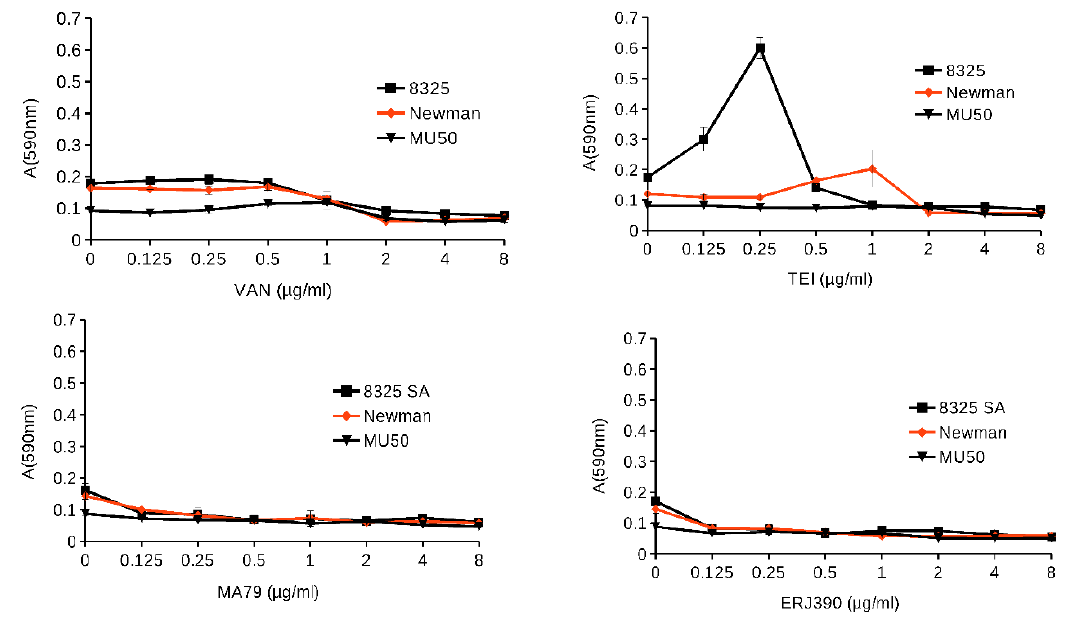
Figure 5. Biofilm formation of S. aureus in the presence of different concentrations of the VAN, TEI, MA79, and ERJ390.